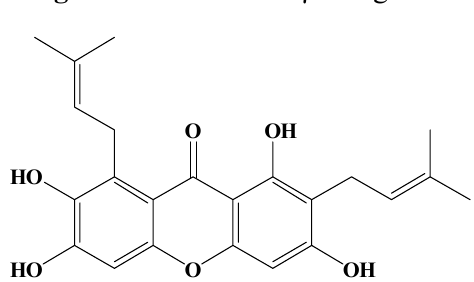
Figure 1. Structure of γ